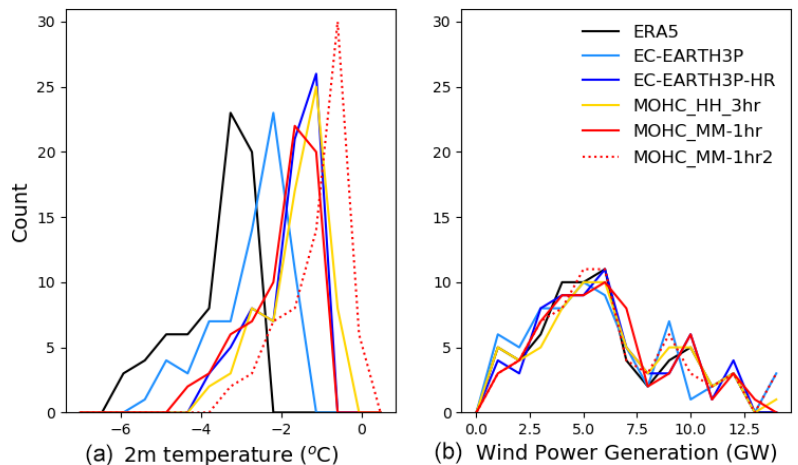
Figure 10. (a) The minimum 70d of GB-average 2m temperatures over the historical period. (b) GB-average daily mean wind power generation on the 70d of lowest temperature for ERA5 (black) and the delta-corrected ERA5 data (colours). See Table 1 for further details of the models used for the delta